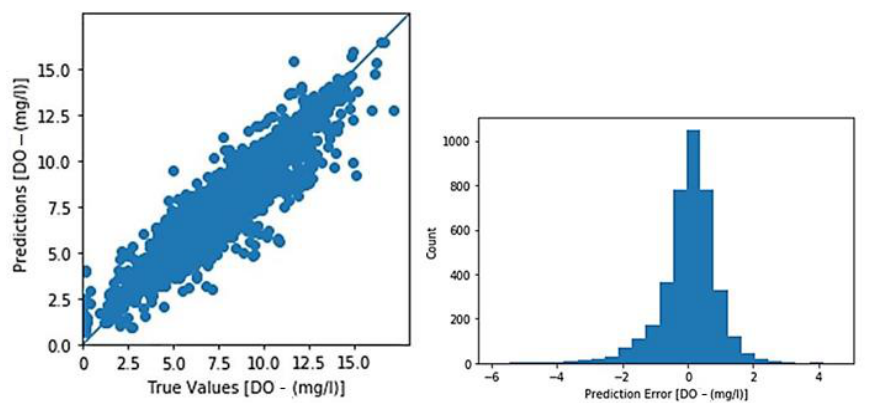
Figure 14. True vs. predicted values ( left ); predicted error ( right ) (Toichio station, structure 4-32-32-1).